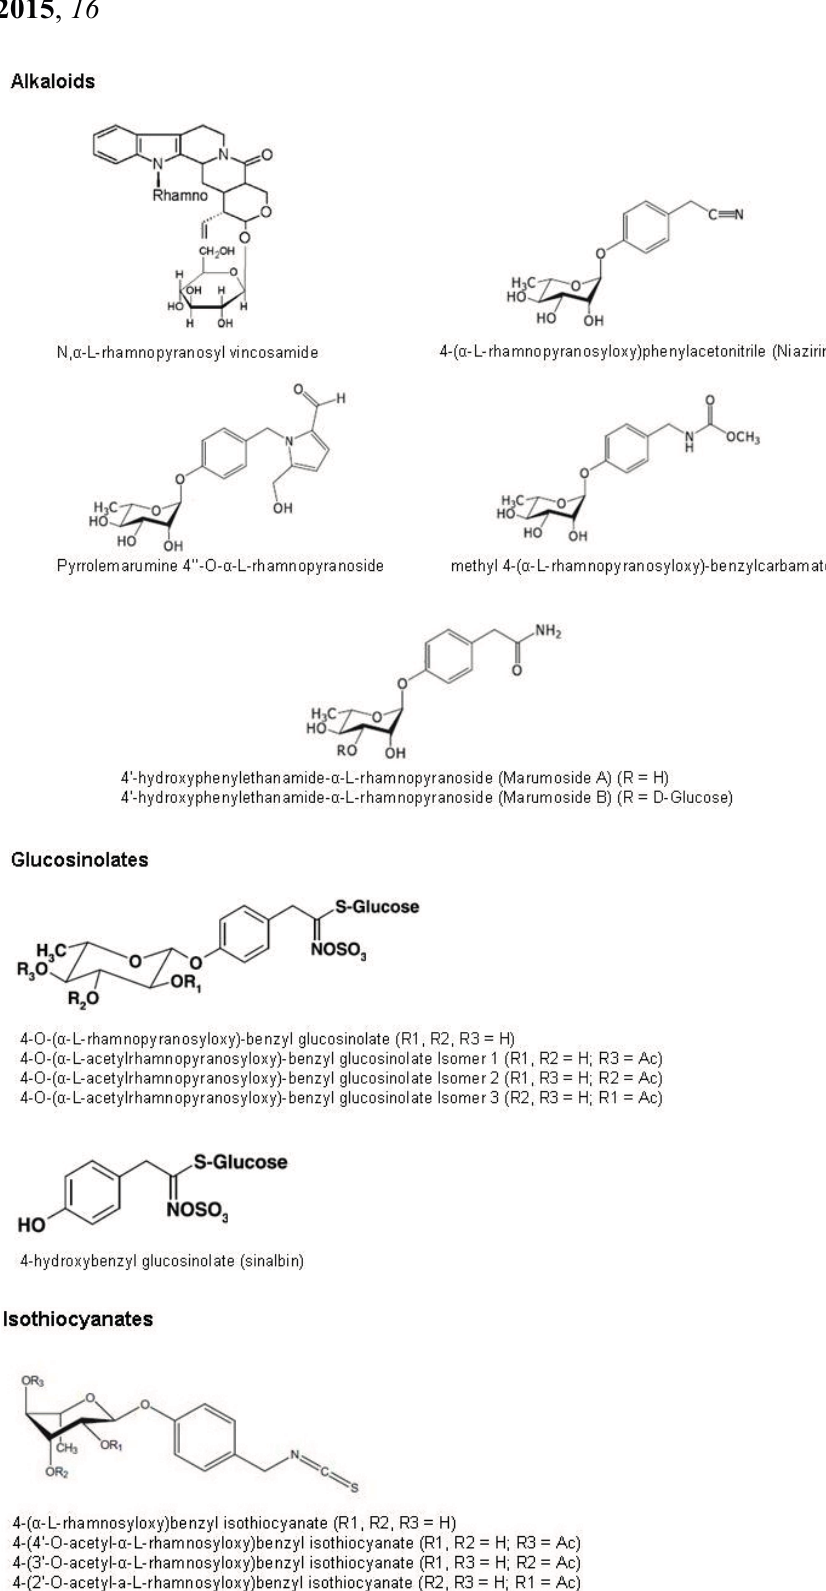
Figure 2. Chemical structure of bioactive compounds found in Moringa oleifera